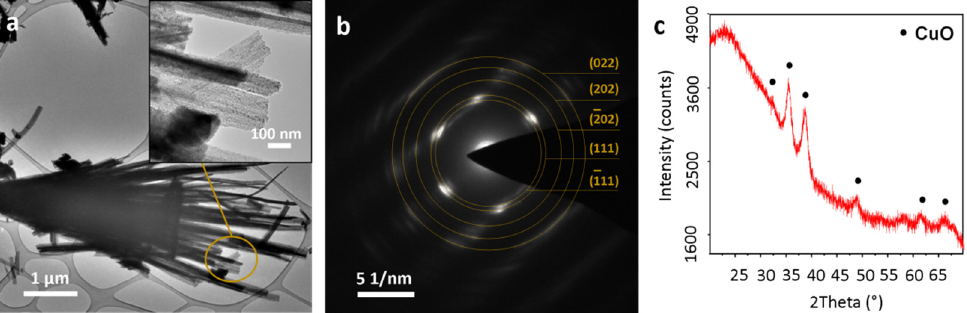
Figure 3. CuO needle-shaped structures detached from the substrate: ( a ) transmission electron microscopy (TEM) images, ( b ) selected area electron diffraction (SAED) pattern of the inset area, ( c ) XRD pattern of CuO film.